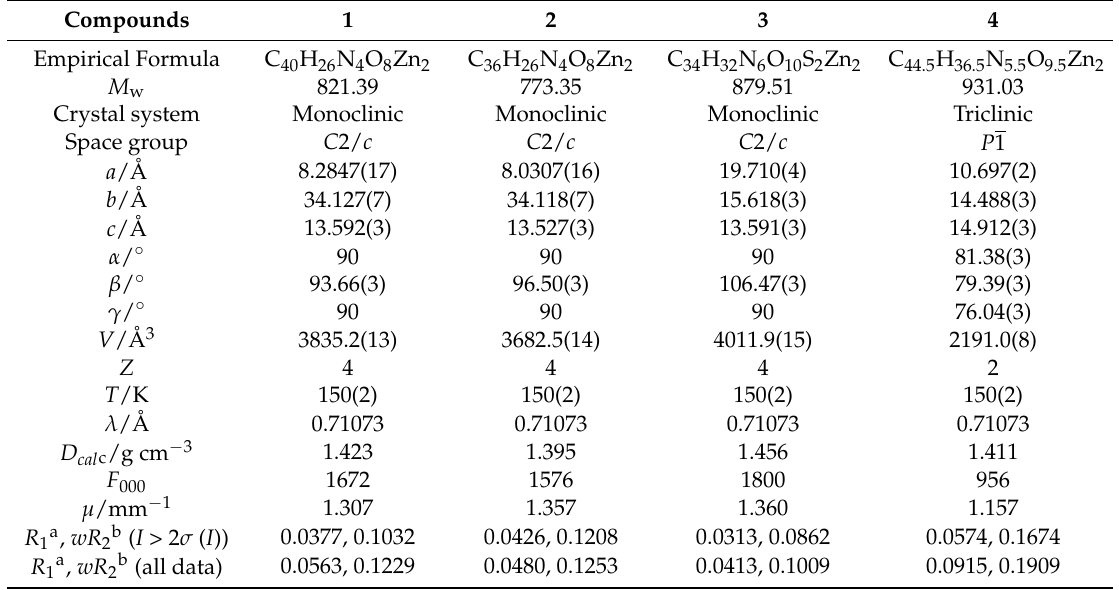
Table 1. Crystallographic data and structure refinement details for compounds 1 – 4 (excluding the squeezed solvent